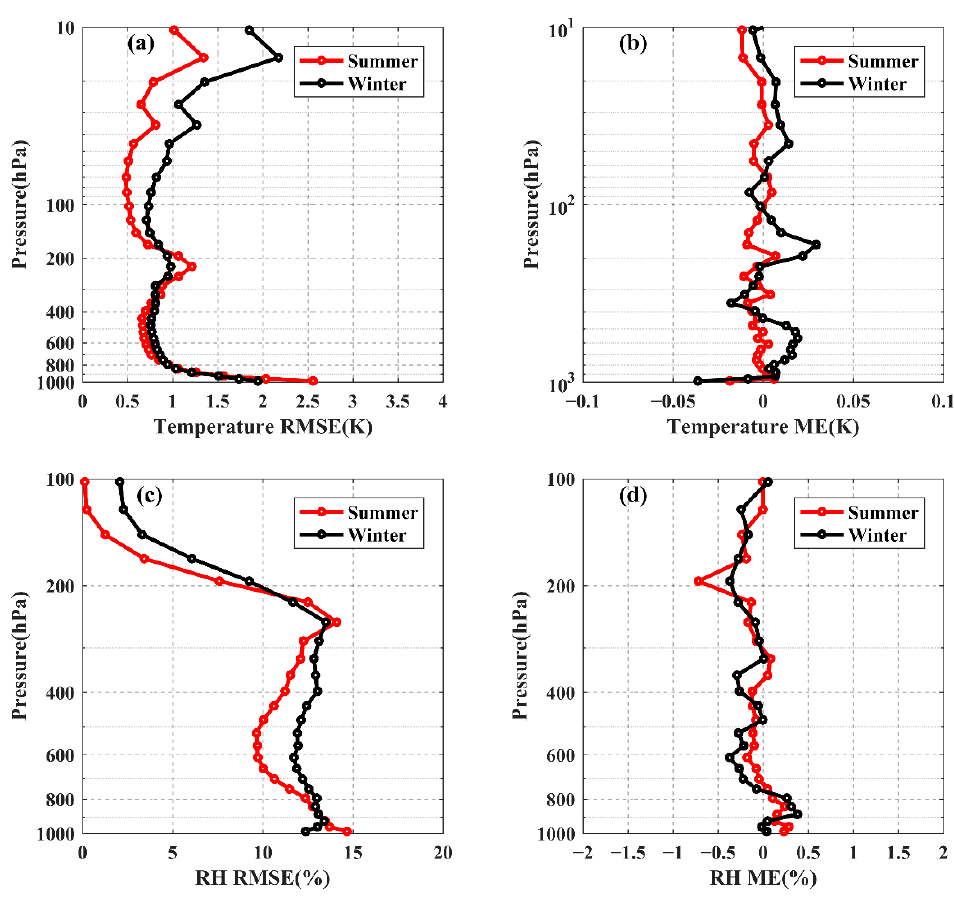
Figure 8. Profile retrieval errors for ( a , b ) temperature, ( c , d ) RH,with respect to ERA5 on ocean.